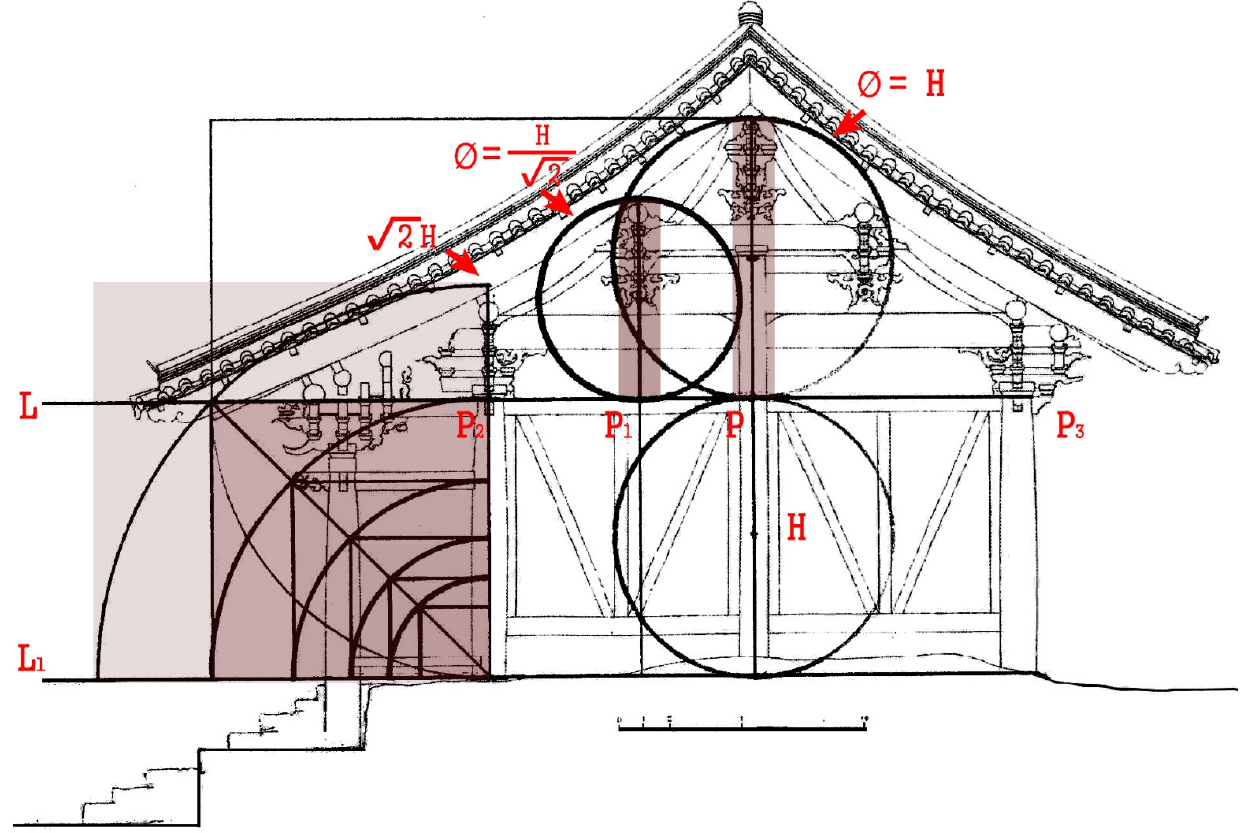
Figure 15. Geungnakjeon Hall of Seongbulsa Monastery. Proportional analysis of the sectional elevation (H = eave column height, Ø = circle diameter), Adapted from CHA (NRICH 1998, p. 38).